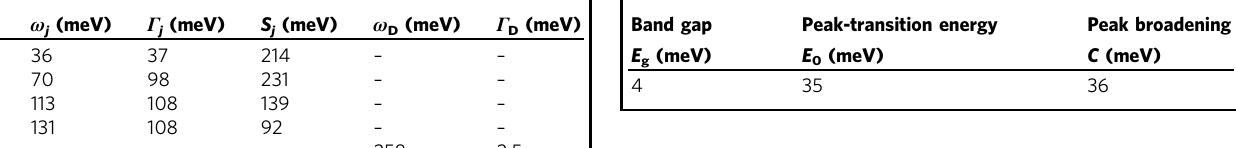
Table 2 Parameters of the Lorentzian and Drude terms. Table 3 Parameters of the Tauc – Lorentzian